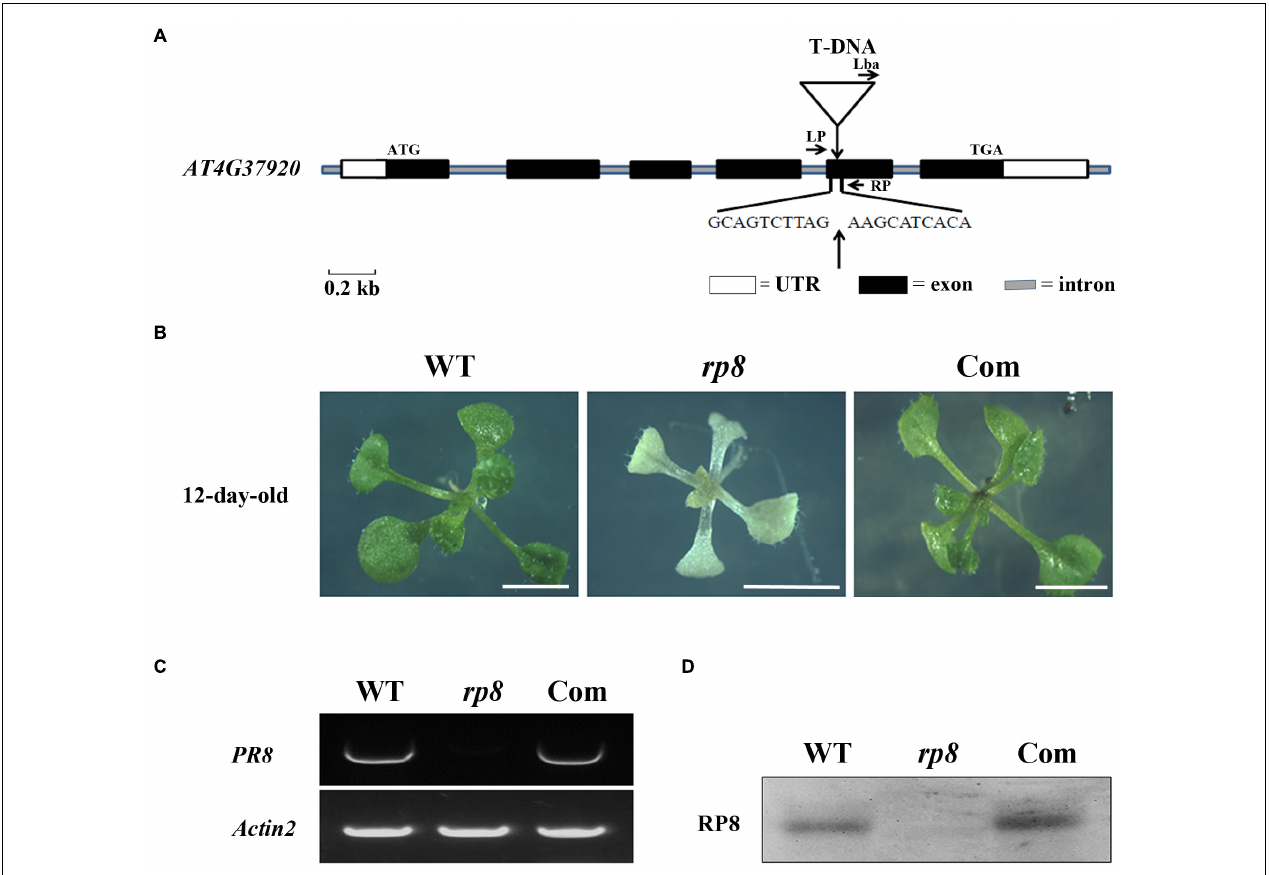
FIGURE 1 | Identification and characterization of the rp8 mutant. (A) Schematic representation of the RP8 gene and the T-DNA insertion. Black boxes represent exons, lines represent introns, and white boxes represent the start and stop regions. The white triangle shows the T-DNA insertion site in the fifth exon of At4g37920. (B) Phenotypes of 12-day-old wild-type (WT), rp8 mutant, and complementation plant (Com). All plants are grown on MS medium containing 2% sucrose under light intensity at 30 µ mol m - 2 s - 1 . Bars = 0.5 cm. (C) RT-PCR analysis of the RP8 gene expression in WT, rp8 mutant, and complementation plants. Actin2 was used as an internal control. (D) Immunoblot analysis of the RP8 protein in WT, rp8 mutant, and complementation plants. Each lane was loaded with 30 µ g total